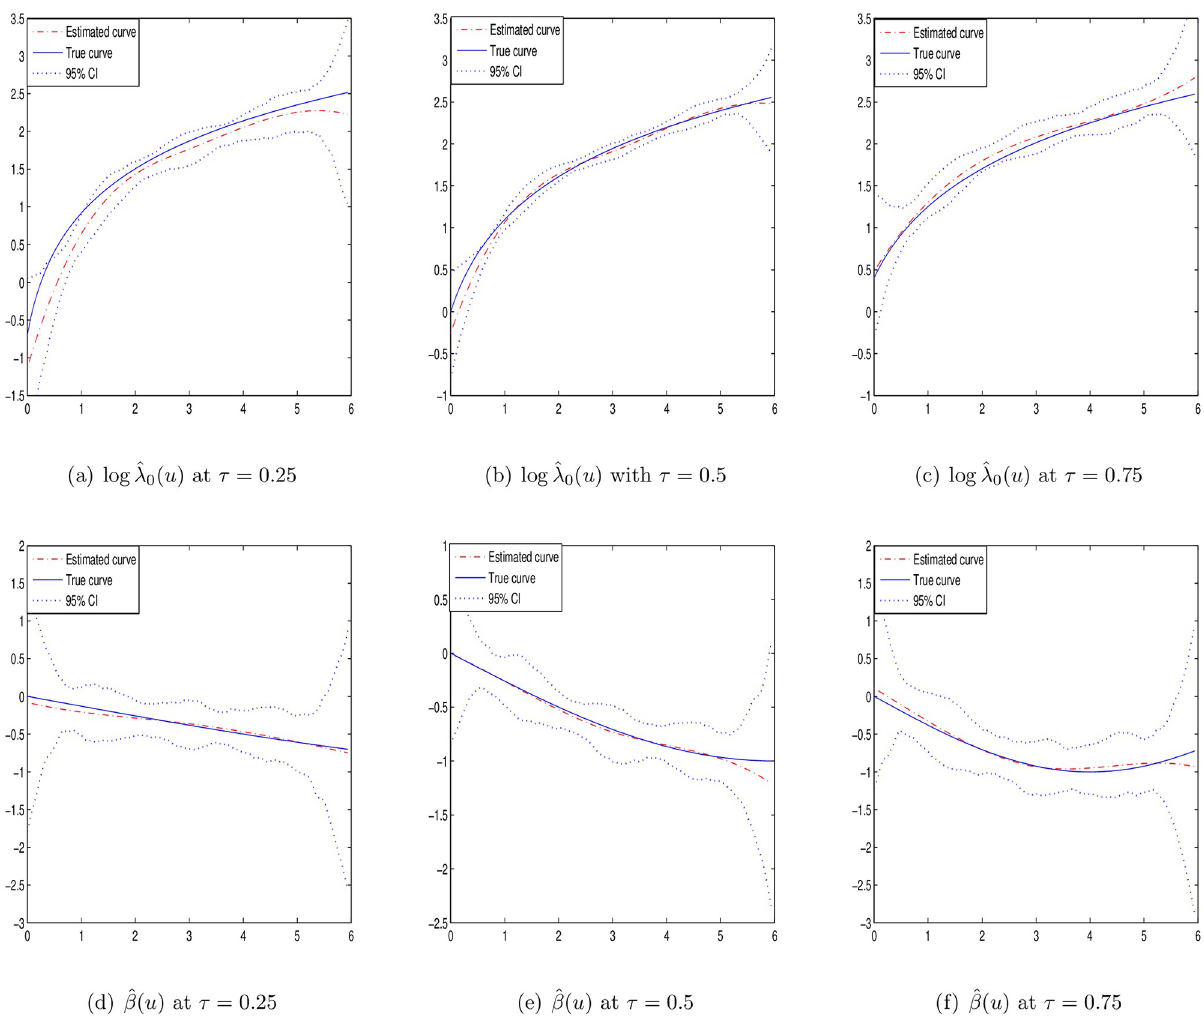
Fig 2. Estimated curves of time-varying functions in case II at different τ with n =